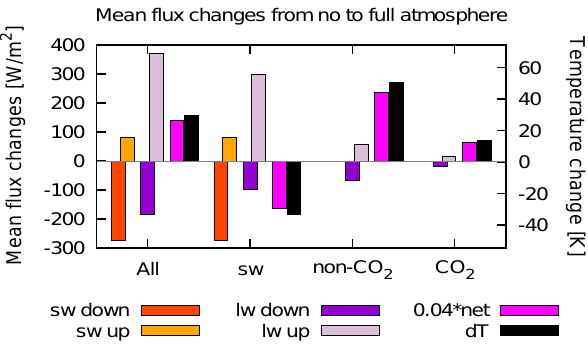
Fig. 4. Summary of Fig. 3. Mean flux changes over the simulation period are shown for the total (“All”) and the regarded tagging cat- egories. Shortwave and longwave fluxes are shown in red and blue, respectively. Downward fluxes are shown in darker colour than up- ward fluxes. The net flux (purple) is scaled for presentation reasons. Temperature changes are in